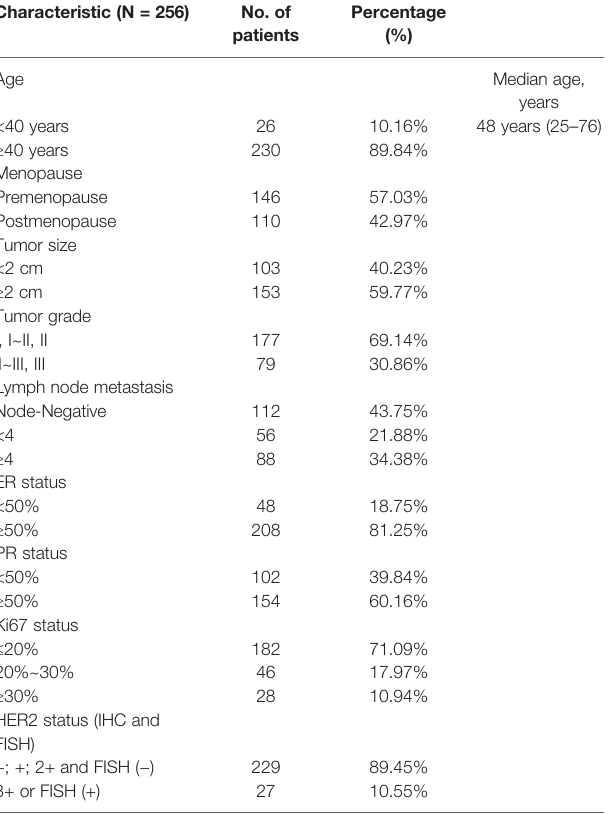
TABLE 1 | Patients ’ information and tumor